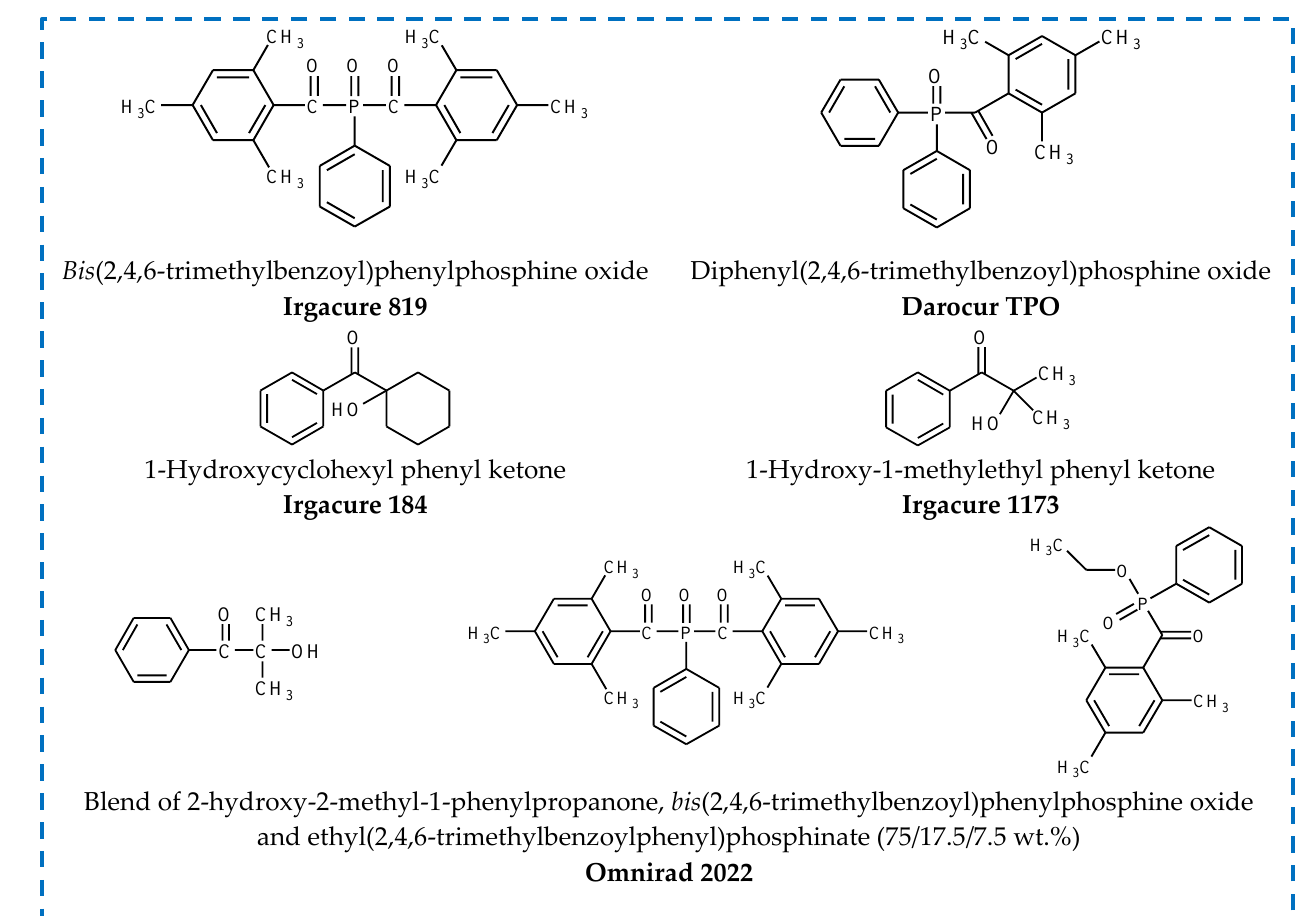
Figure 2. Examples of commonly used type I photoinitiators.